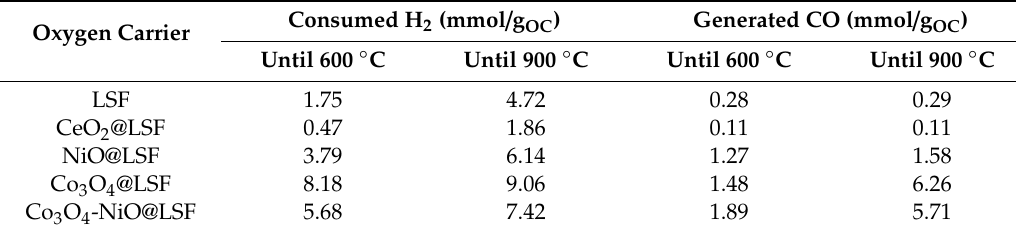
Table 2. Results of H 2 -TPR and CO 2 -TPO